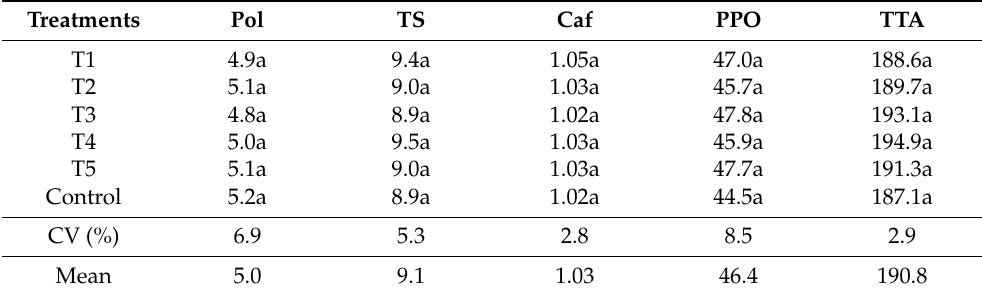
Table 2. Variables analyzed in the coffee beans for the harvest of 2018/2019. Treatments